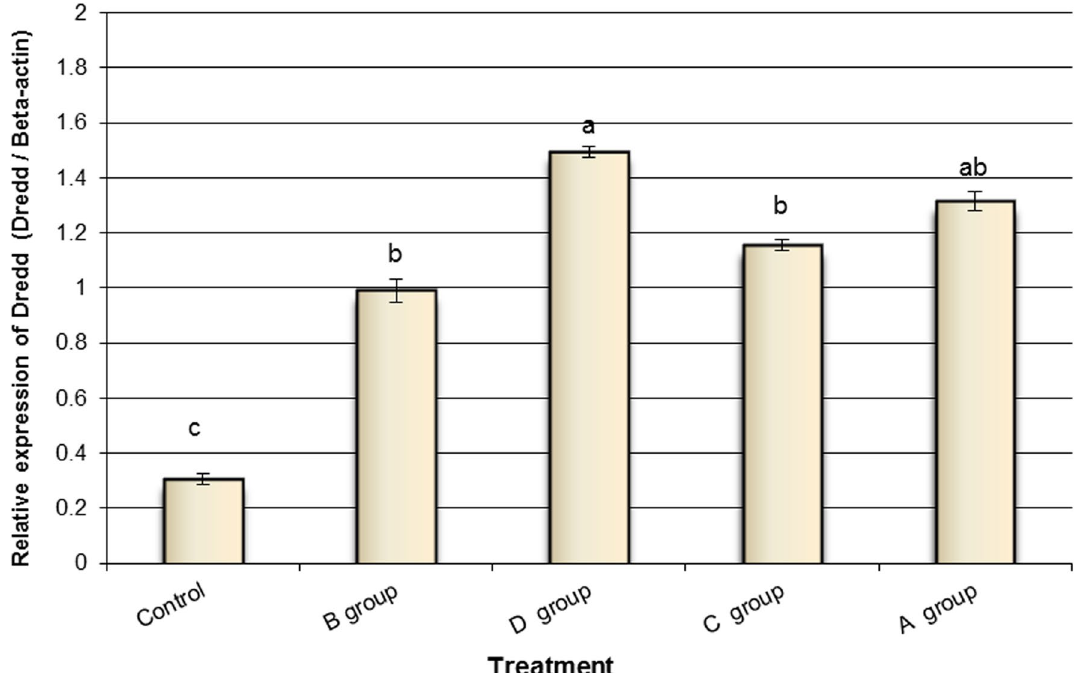
Fig. 3 The Dredd gene expression is altered in insect tissues that have been exposed to various bacterial bio‑insecticides. Data are displayed as mean SEM. Within tissues, mean values with dissimilar superscript letters showed a statistically significant difference (a: P0.01, b: